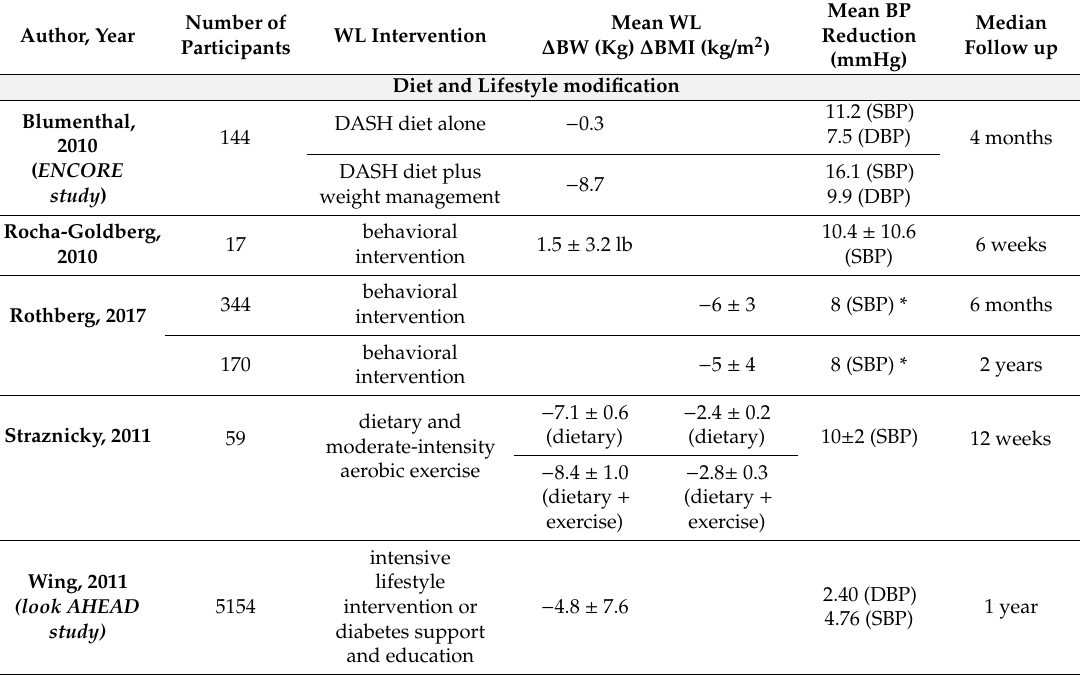
Table 1. This table summarizes selected studies from the last 10 years, showing a positive e ff ect of weight loss (WL) on blood pressure (BP), achieved by diet and lifestyle modifications, pharmacological intervention and bariatric surgery. The table includes only studies with available data regarding number of participants, WL strategies, quantifiable mean WL and mean BP decrease, median follow-up time. * mean values referred to patients who achieved the major waist circumference